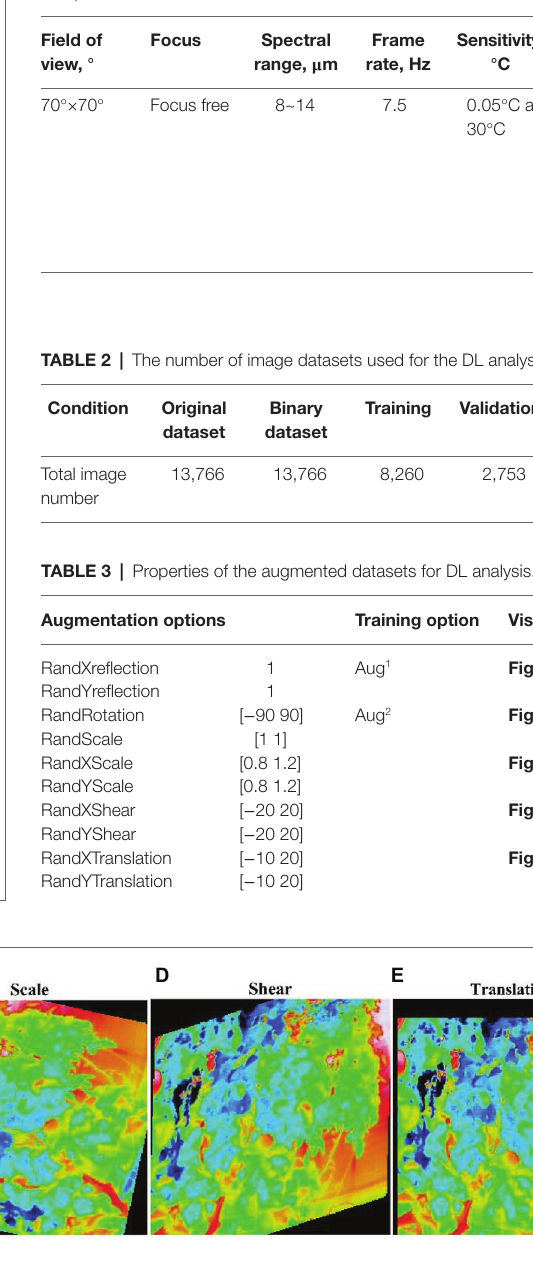
FIGURE 6 | Augmented image dataset. The statistics of the image datasets used for the deep learning (DL) network analysis are shown in Table 2 . (A) Reflection; (B) Rotation; (C) Scale; (D) Shear; and (E) Translation.